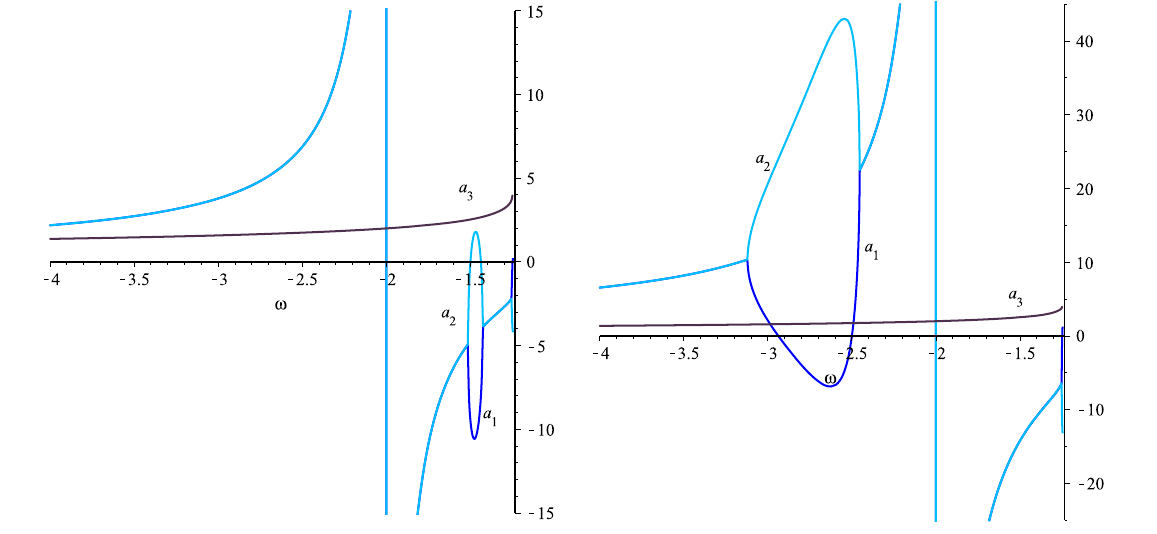
Fig. 4 Real parts of the eigenvalues corresponding to P 5 − , with n = 2 (left) and n = 4 (right). a 1 and a 2 are singular at ω = − 2